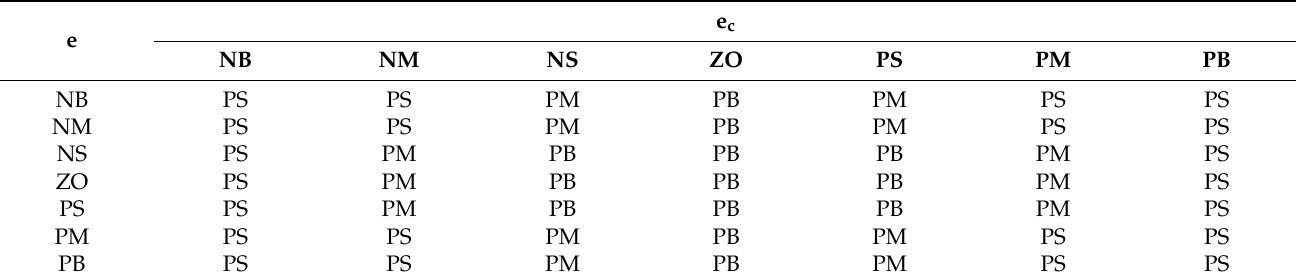
Table 3. The fuzzy rules matrix of Δk d .